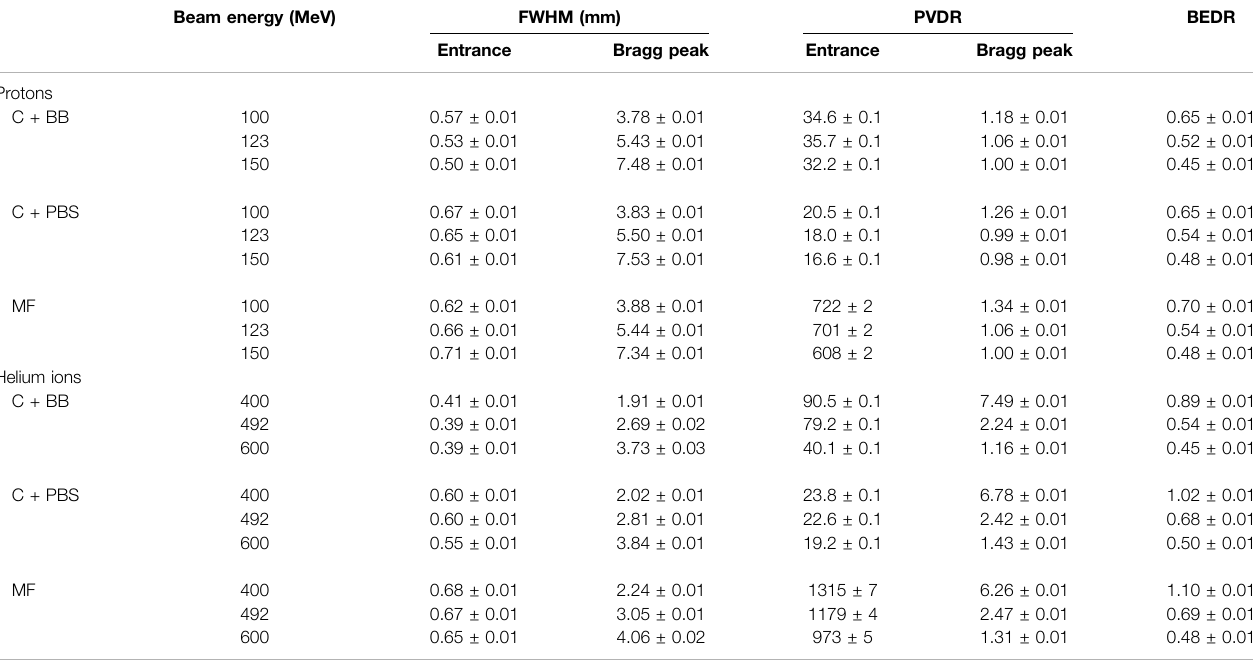
TABLE 1 | FWHM and PVDR at phantom entrance and Bragg peak depth and BEDR of all considered